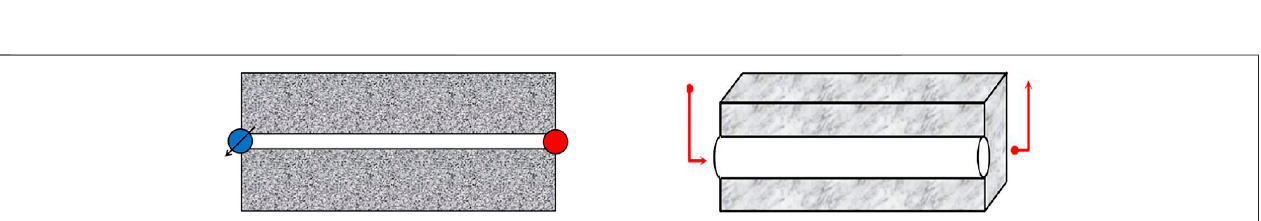
FIGURE2| Traceroutputcurveofinterwellsinglefractureunderdifferentparameters. (A) different l ( b =40 μ m, h =6 m, Δ P =5 MPa) (B) different b ( l =600 m, h =6 m, Δ P =5 MPa) (C) different h ( l =600 m, b =40 μ m, Δ P =5 MPa) (D) different Δ P ( l =600 m, b =40 μ m, h =6 m).